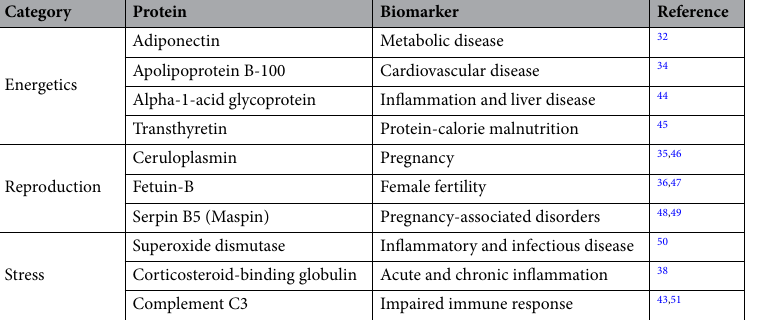
Table 1. The influence of landscape condition was assessed to predict the expression of target proteins quantified in grizzly bear skin related to energetics, reproduction, and stress. Table modified from Wilson et al., 2020.